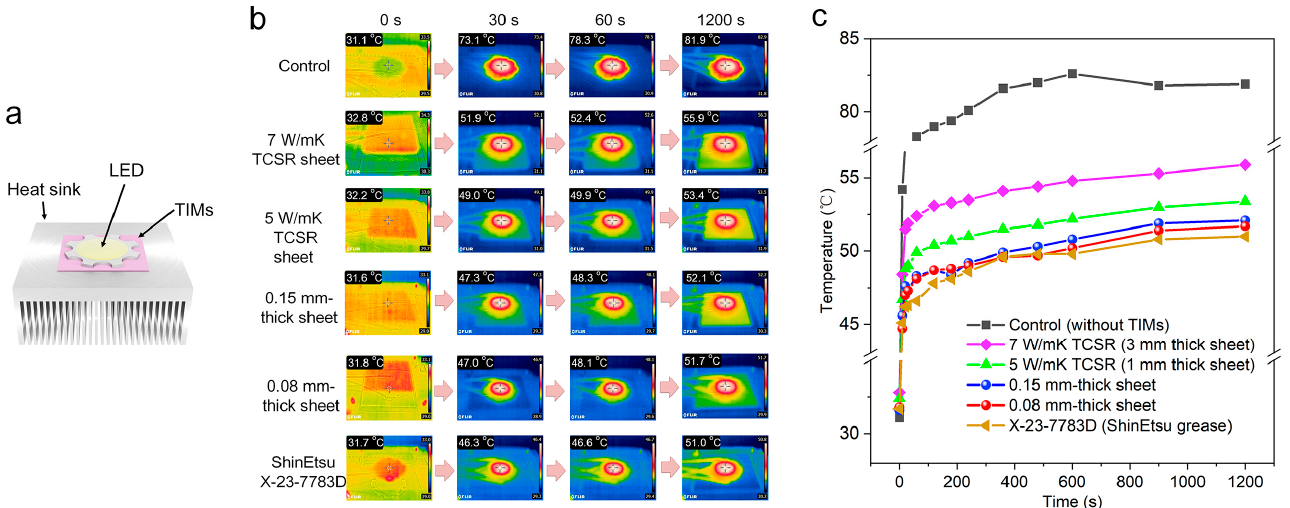
Figure 5. ( a ) Schematic diagram of the homemade setup for the cooling tests. ( b ) Typical infrared images showing the working temperature of the LED chips. ( c ) Plots of the working temperature of the LED chips with different TIMs against working time.